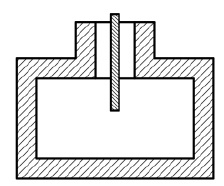
Fig. 1. Methods for exciting waves in a rectangular waveguide for H-type waves.